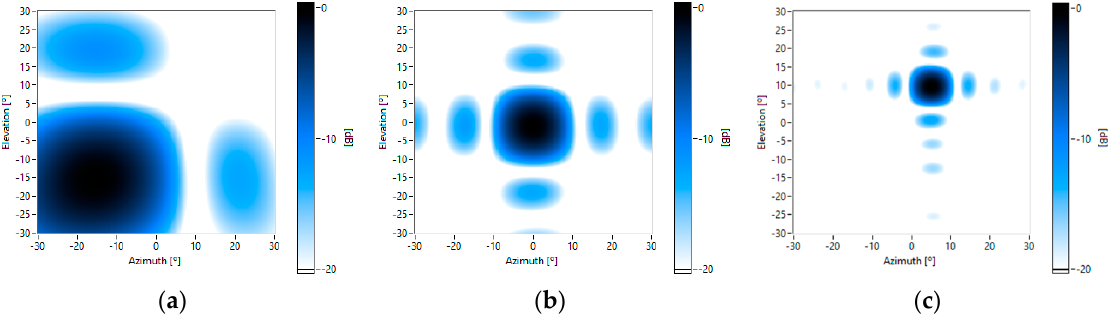
Figure 9. Measured beam patterns for different frequencies and pointing to different steering angles [azimuth, elevation]: ( a ) 4 kHz and [ − 15°, − 15°]; ( b ) 8 kHz and [0°, 0°]; and ( c ) 16 kHz and [5°,